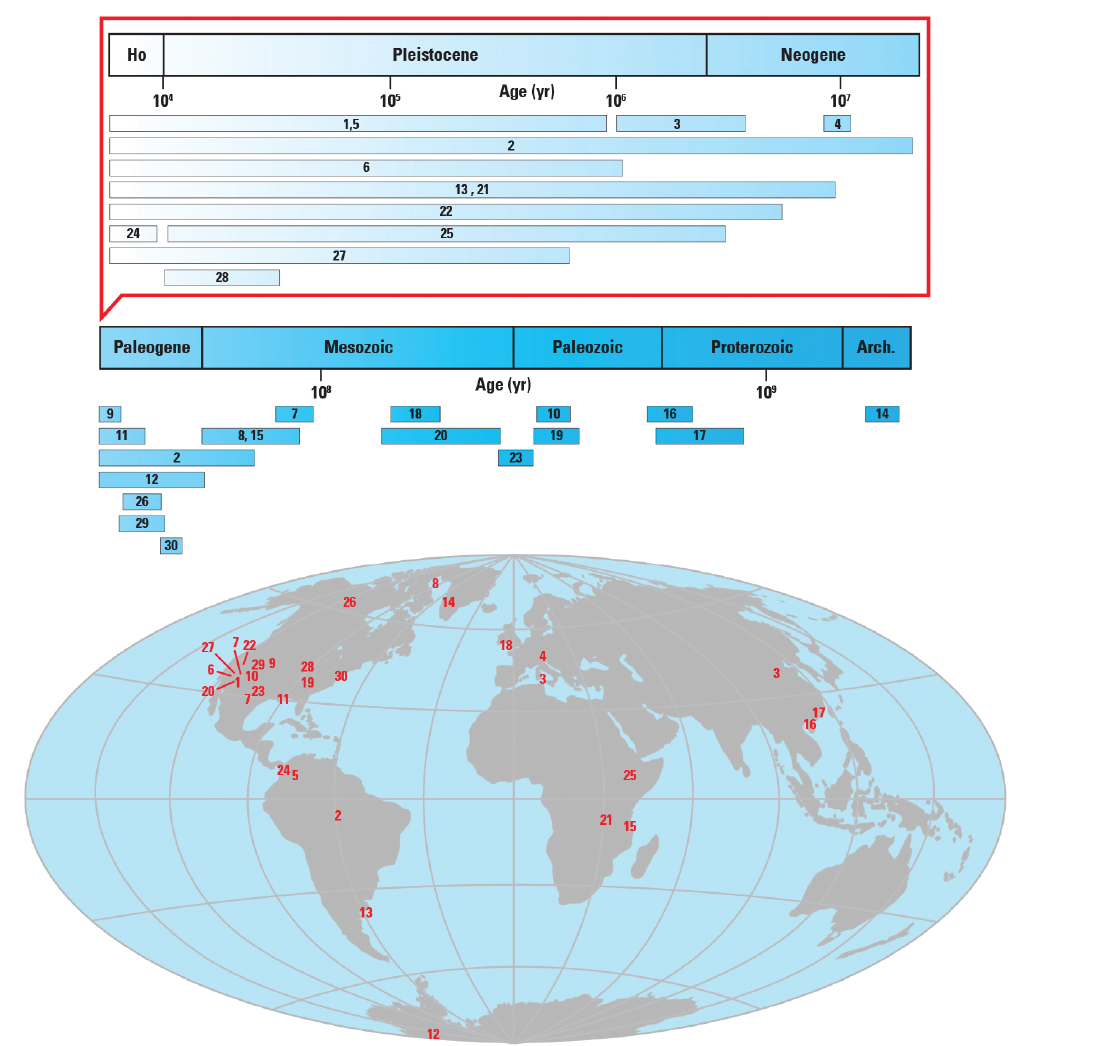
Figure 1. Geologic timescale (above) and global map (below) listing the (enumerated) 30 drilling project pre-proposals submitted to this workshop. The gray to black bars show the various timescales of the projects proposed. Note that the upper timescale is an enlarged version of the Holocene through Neogene interval, to portray projects proposed for this “near-time” slice. See Appendix Table A1 for the titles of the proposed projects (key to the numbers in the bars in this